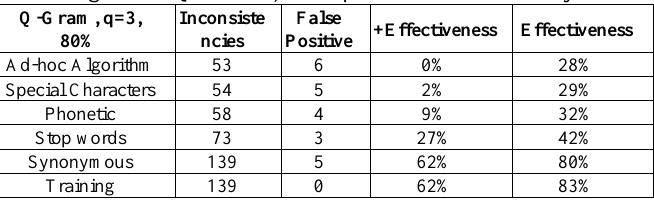
Table 4: Results obtained with data cleaning process using the algorithm Q-Grams, with q=3 and 80% similarity.